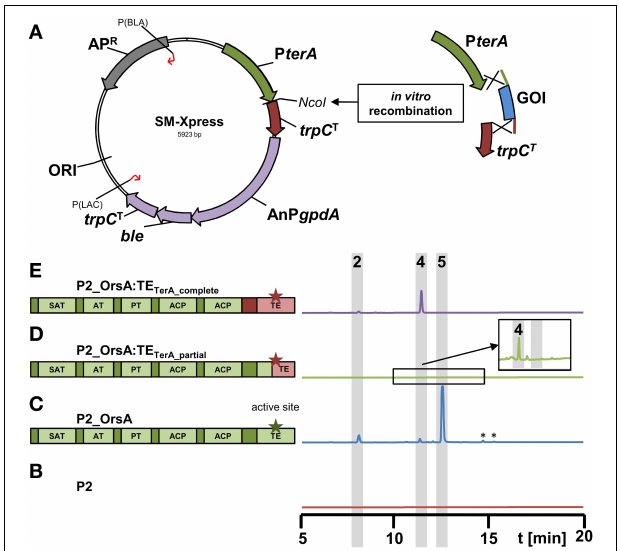
FIGURE 6 | Scheme of the new expression vector SM-Xpress and its use for rapid cloning of polyketide synthases in domain swapping experiments. (A) The plasmid SM-Xpress contains the native terA promoter and a trpC terminator and allows cloning of a gene of interest (GOI) by restriction cloning or in vitro recombinantion into the Nco I site. Due to a phleomycin resistance cassette (AnP gpdA:ble:trpC T ), the plasmid is suitable for direct transformation of the A. niger P2 strain expressing terR under P amyB control. (B–E) HPLC profiles of culture filtrates from A. niger P2 strains grown for 40h in AMM-G100 + Gln50 and expressing different versions of the original A. nidulans orsA gene or chimeric versions with exchanged thioesterase (TE) domains as depicted in the schemes on the left. Green parts originate from orsA and pink parts from A. terreus terA . Asterisks indicate the active sites of the TE domains. (B) P2 control strain (P amyB : terR ), (C) P2_A1144_P terA : orsA, (D) P2_P terA:orsA:TE terA_partial and (E) P2_P terA:orsA:TE terA _ complete . Indicated peaks correspond to 4-hydroxy-6-methylpyrone (2), orsellinic acid (4) and lecanoric acid (5). Note that a partial exchange of the TE domain (D) leads to a chimeric protein that hardly releases products and only trace amounts of orsellinic acid are detected (magnified inlay). ∗ Indicate non-reproducible metabolite